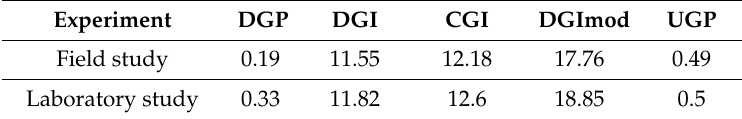
Table 3. Grand mean of each discomfort glare index value for both datasets.